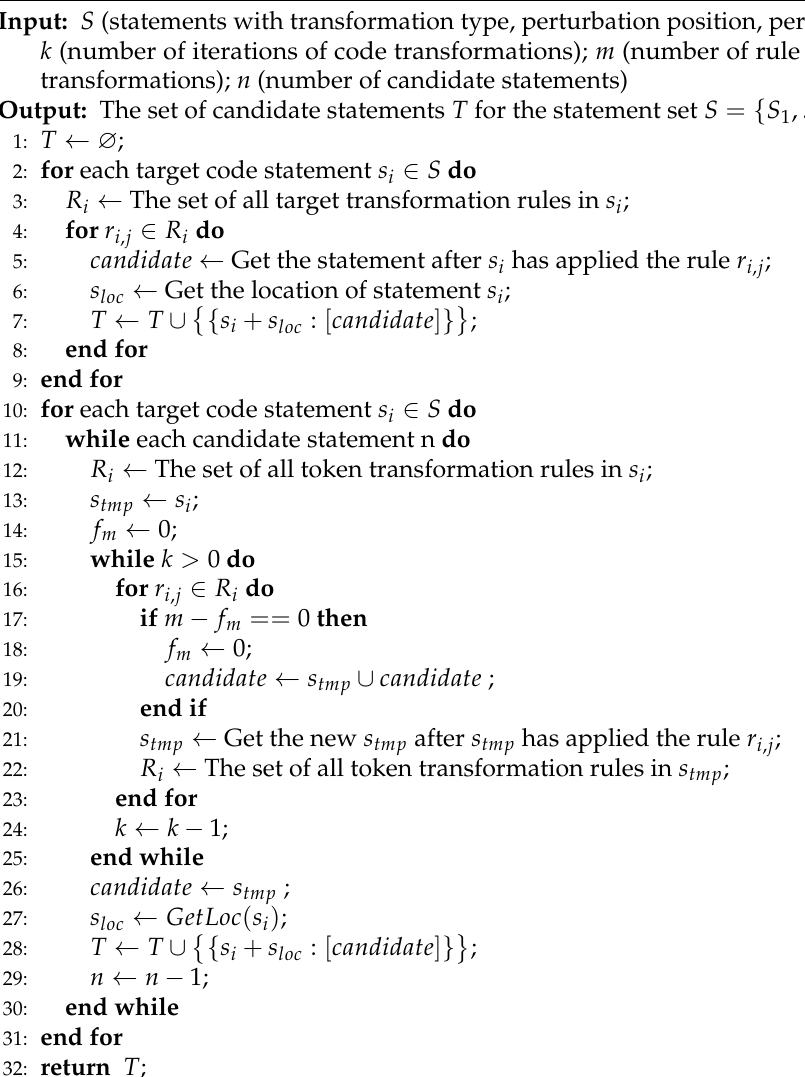
Algorithm 2 Generating candidate statements for perturbation